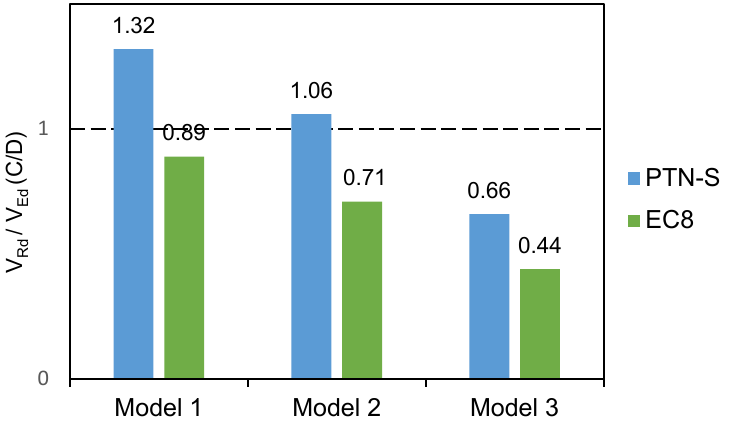
Figure 25. Seismic capacity versus demand (C/D) ratio for the ground floor of the building in N–S direction (for the original building).